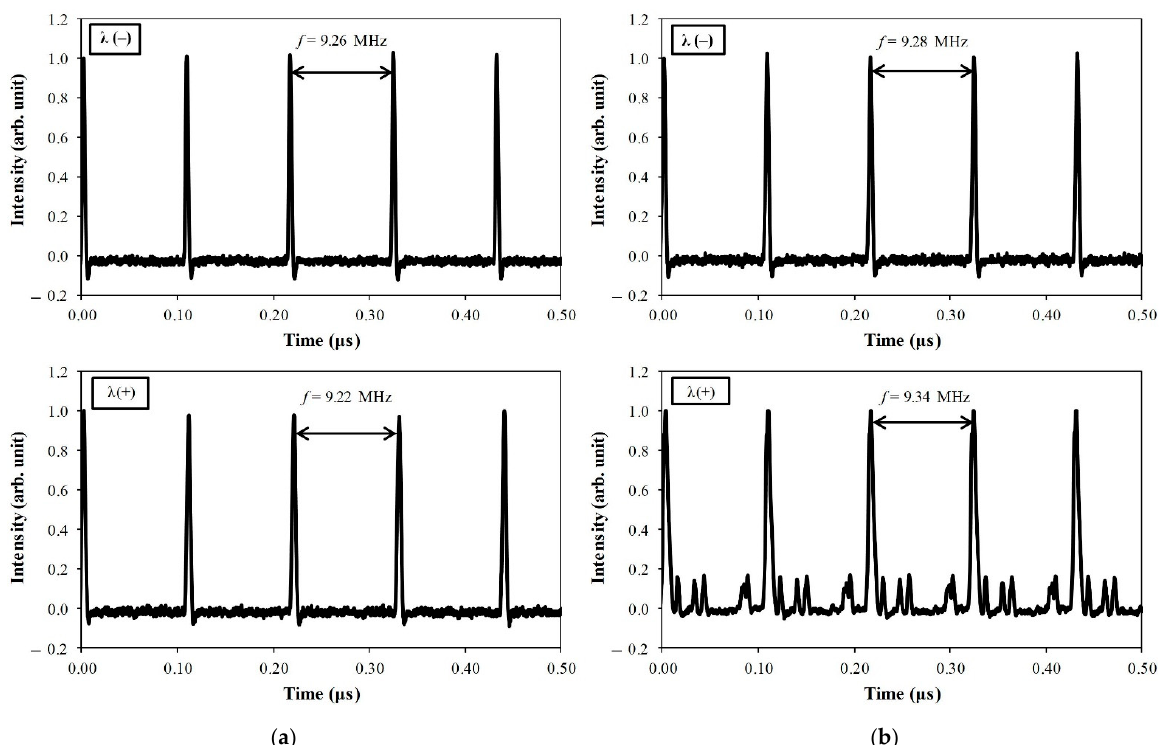
Figure 6. Pulse train for ( a ) unidirectional DWML-EDFL and ( b ) bidirectional DWML-EDFL. Figure 7 a,b shows the radio frequency (RF) spectrum of the mode-locked output at fundamental frequency peak for unidirectional and bidirectional DWML-EDFL, respec- tively, which are measured at the RF span of 1 MHz and resolution bandwidth of 30 kHz. For λ ( − ) and λ (+) signals in unidirectional DWML-EDFL, the peak-to-pedestal extinction ratios (PER) are 40.78 dB and 39.53 dB, respectively. On the other hand, for λ ( − ) and λ (+) signals in bidirectional DWML-EDFL, the measured PERs are 42.92 dB and 37.70 dB, re- spectively.